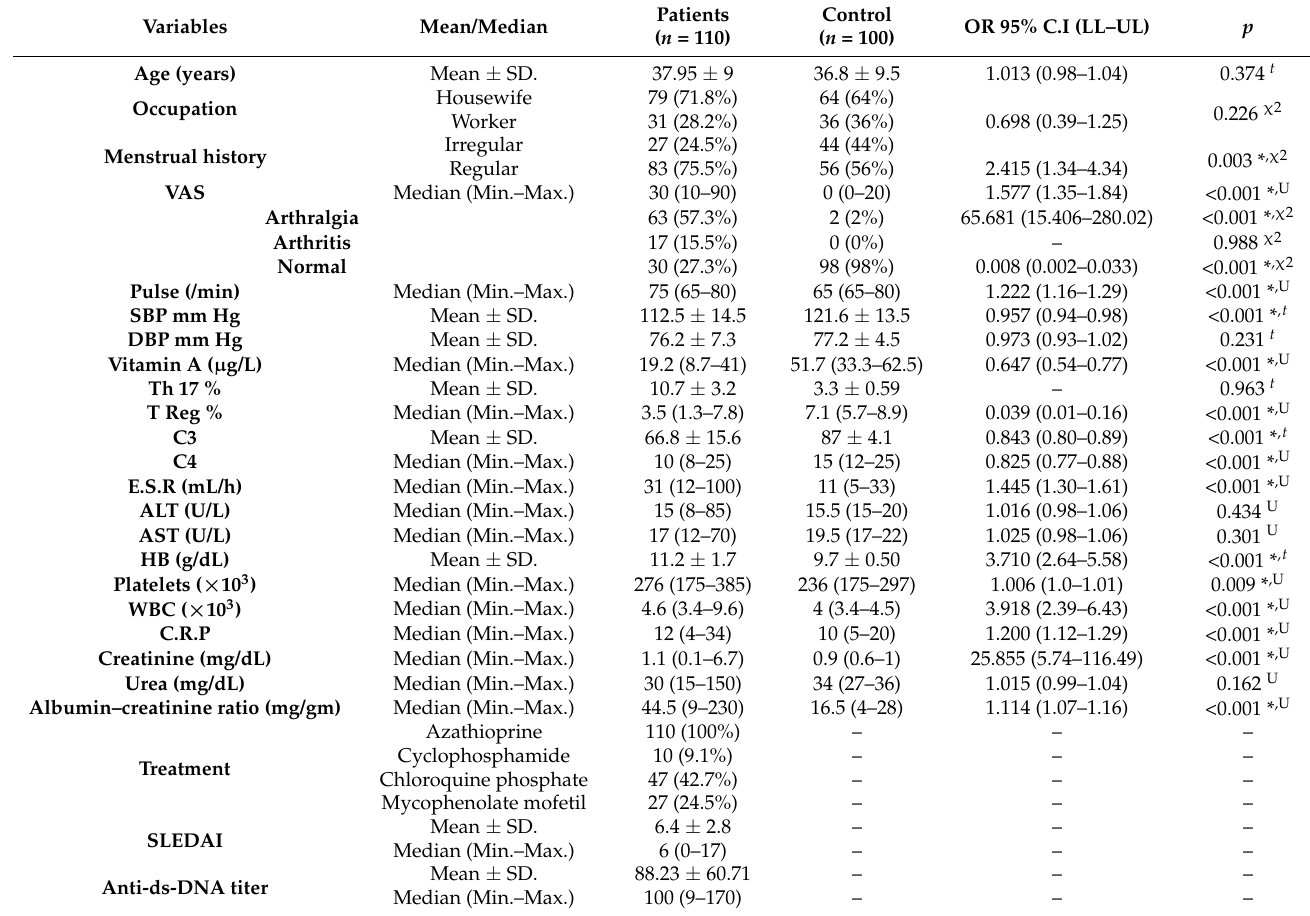
Table 1. Comparison between the two studied groups according to different parameters.